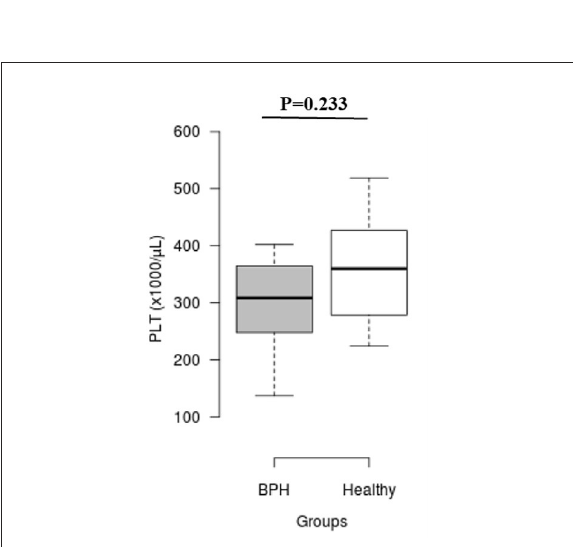
FIGURE3 Box plots of plateletcrit (PCT) in BPH and Healthy groups. Center lines show the medians; box limits indicate the 25th and 75th percentiles. n = 24, 11 sample points.